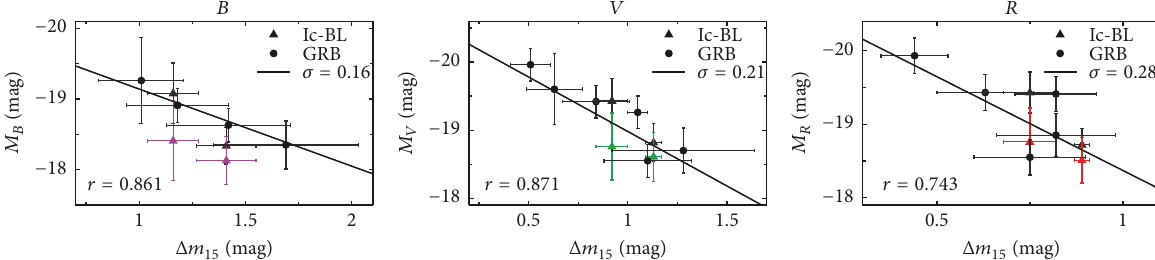
Figure 14: Luminosity − decline relationships of relativistic SNe IcBL (GRB-SNe: filled circles; SNe IcBL: filled triangles) in filters 𝐵 (purple), 𝑉 (green), and 𝑅 (red), from [44]. Solid black lines and points correspond to absolute magnitudes calculated for luminosity distances, while coloured points and lines correspond to absolute magnitudes calculated for those events where independent distance measurements have been made to the SN’s host galaxy. The correlation coefficient for each dataset is shown (in black and in their respective colours) as well as the best-fitting luminosity − decline relationship determined using a bootstrap method and the corresponding rms ( 𝜎 ) of the fitted model. It is seen that statistically significant correlations are present for both the GRB-SNe and combined GRB-SN and SN IcBL samples. B V R